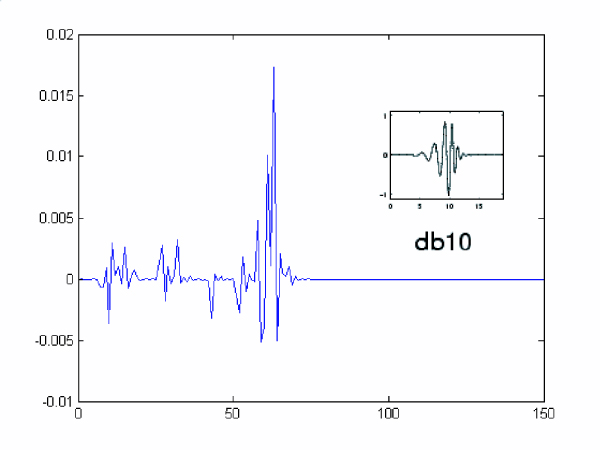
Features obtained for an 8GC hairpin after applying a 10th order Daubechies wavelet filter.